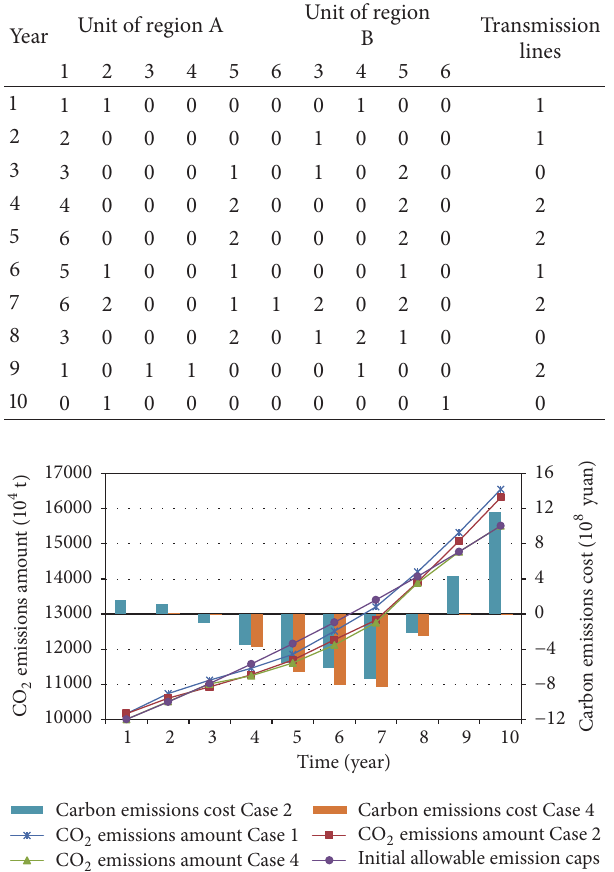
Figure 6: CO 2 emission amount and cost in Case 4.